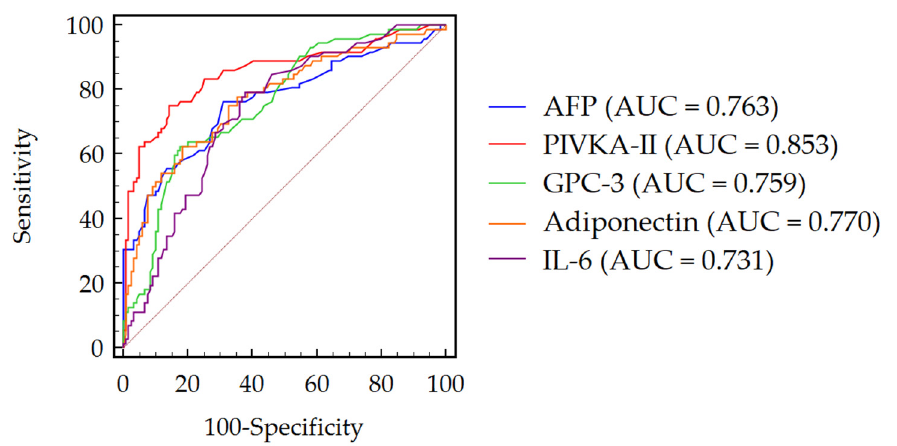
Figure 3. ROC curves of AFP, PIVKA-II, GPC-3, adiponectin and IL-6 discrimination between patients with and without HCC. Abbreviations: alpha-fetoprotein (AFP), area under the curve (AUC), glypican 3 (GPC-3), interleukin-6 (IL-6) and protein induced by vitamin K absence or antagonist II (PIVKA-II).